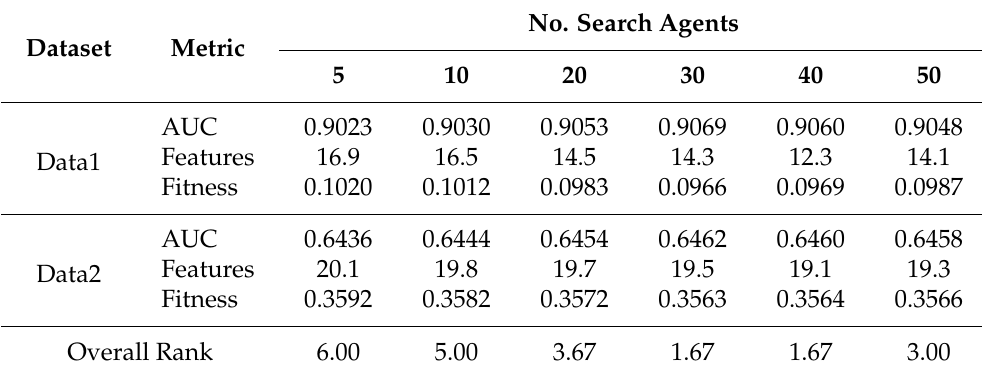
Table 8. Evaluation results of WOA-S2 with different number of search agents for the re-balanced